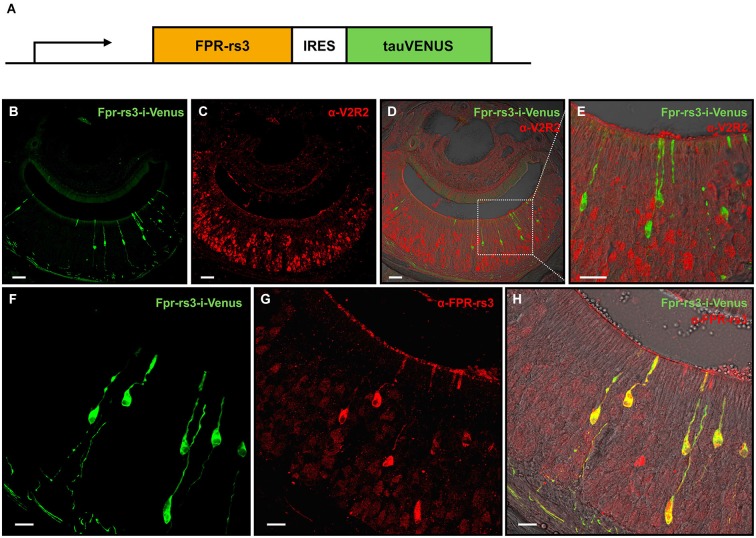
Generation and characterization of the Fpr-rs3-i-Venus transgenic mouse line. (A) Schematic of the transgene that includes an OR promoter/enhancer, followed by the coding sequence of FPR-rs3 and a polycistron that drives the tau-Venus fluorophore. (B) Confocal image of a coronal VNO cryosection showing sparsely distributed fluorescently labeled FPR-rs3+ VSNs (green) in the sensory neuroepithelium. (C) Confocal image displaying a coronal VNO cryosection immunostained with an antibody against V2R2 (red), a family-C V2R expressed in most basal VSNs. (D) Overlay of FPR-rs3 tau-Venus fluorescence and anti-V2R2 staining shows no co-localization of apically located FPR-rs3+ and basal V2R2 expressing neurons. (E) Higher magnification of the boxed area in (D) illustrating the absence of overlapping fluorescence. (F) Confocal image of a VNO cryosection showing distinct green fluorescent FPR-rs3+ sensory neurons (green). (G) Confocal image displaying the same area as in (F) stained against the FPR-rs3 protein (red). (H) Overlay of tau-Venus fluorescence and antibody staining against the FPR-rs3 protein. Note that all transgene-positive cells also express FPR-rs3 (yellow). Scale bars, 50 µm (B–D), 10 µm (E) and 20 µm (F–H).